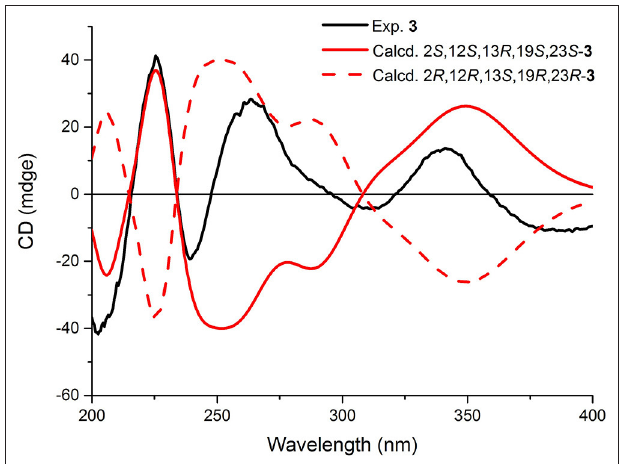
FIGURE 7 | Experimental and calculated ECD spectra of compound 3 .